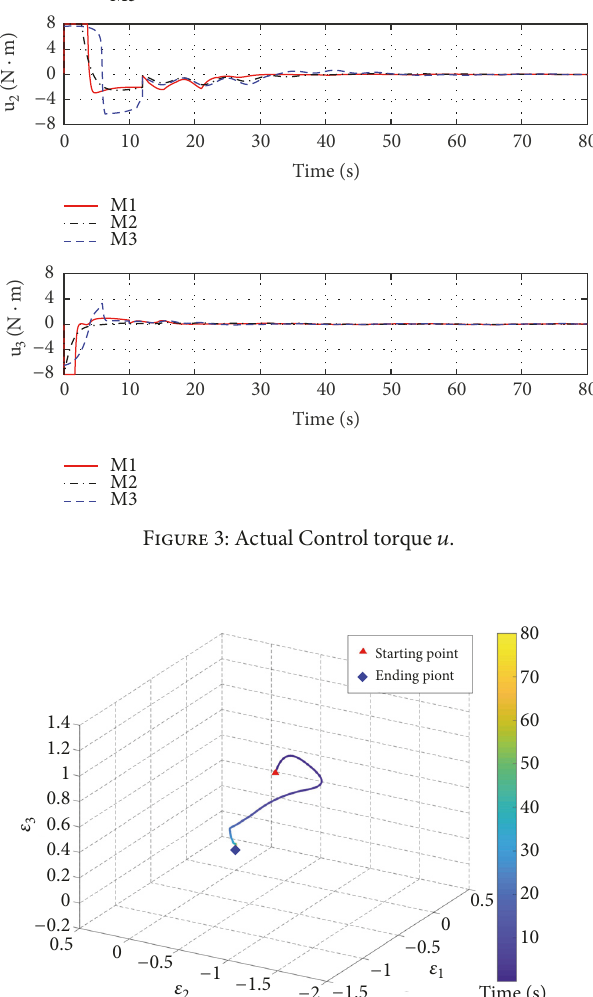
Figure 5: Estimated parameter